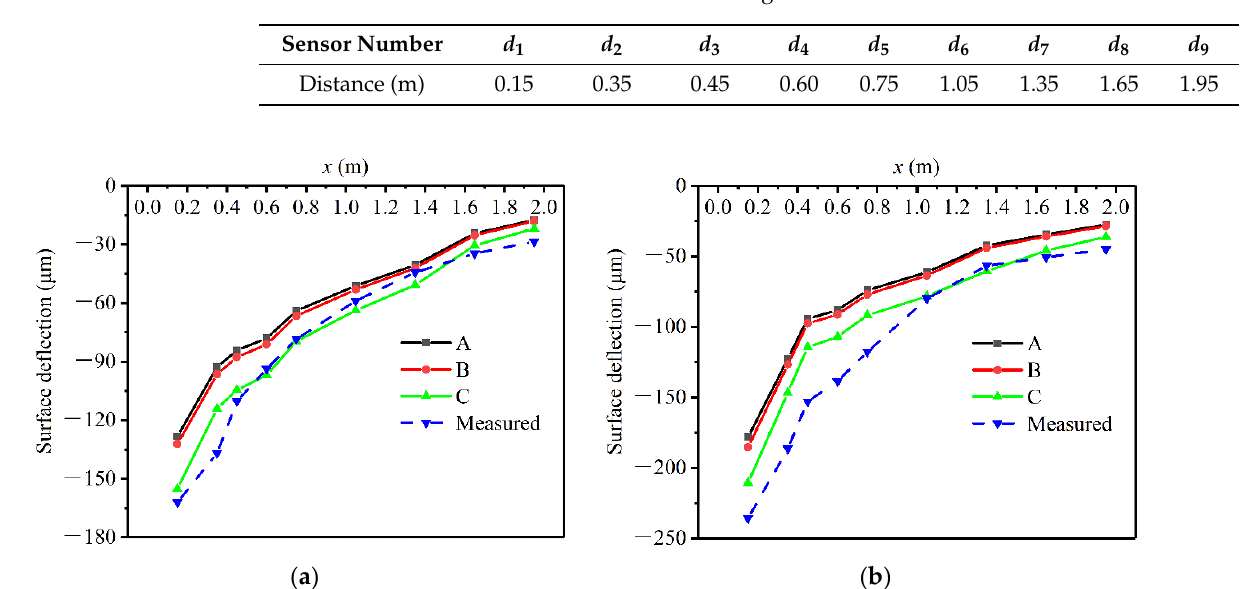
Figure 6. Comparison between the FWD data and anisotropy model of surface defection: ( a ) Structure A. ( b ) Structure B.